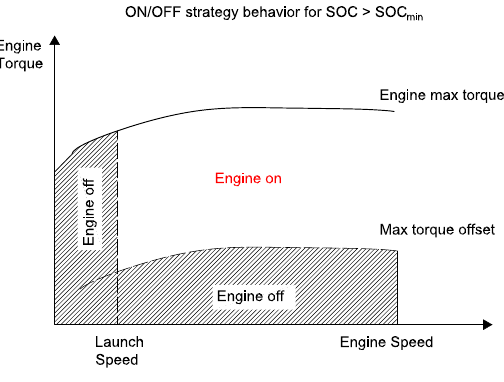
Figure 5. The operating modes of the ON/OFF strategy